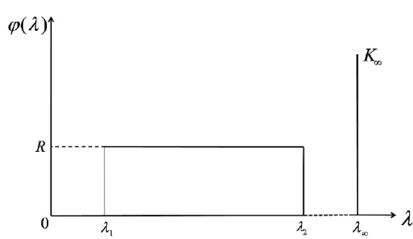
Figure 16. Distribution function.